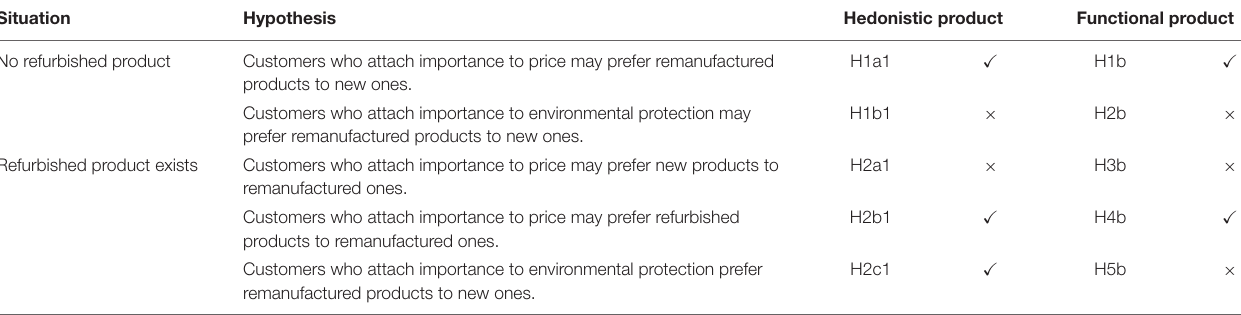
TABLE 8 | Consumer choice motivation hypothesis.